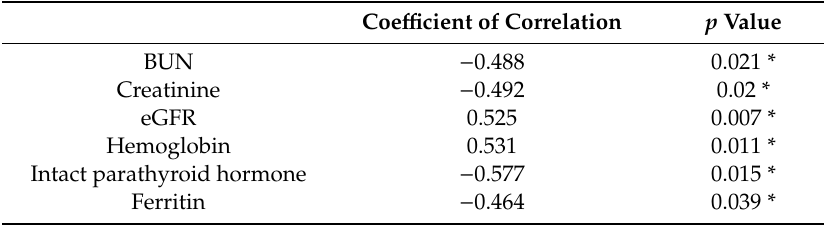
Table 5. Correlation of the TRODAT ratio and the biochemical results in the control and ESRD with RLS groups. Coe ffi cient of